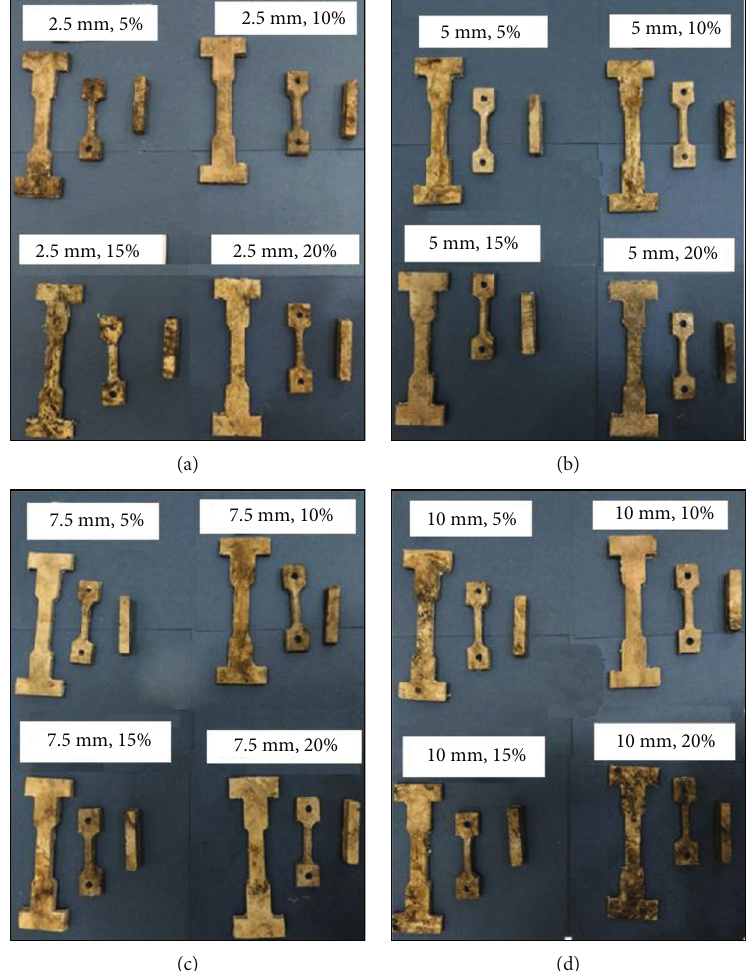
Figure 3: Di ff erent types of specimens with di ff erent lengths and weight ratios of